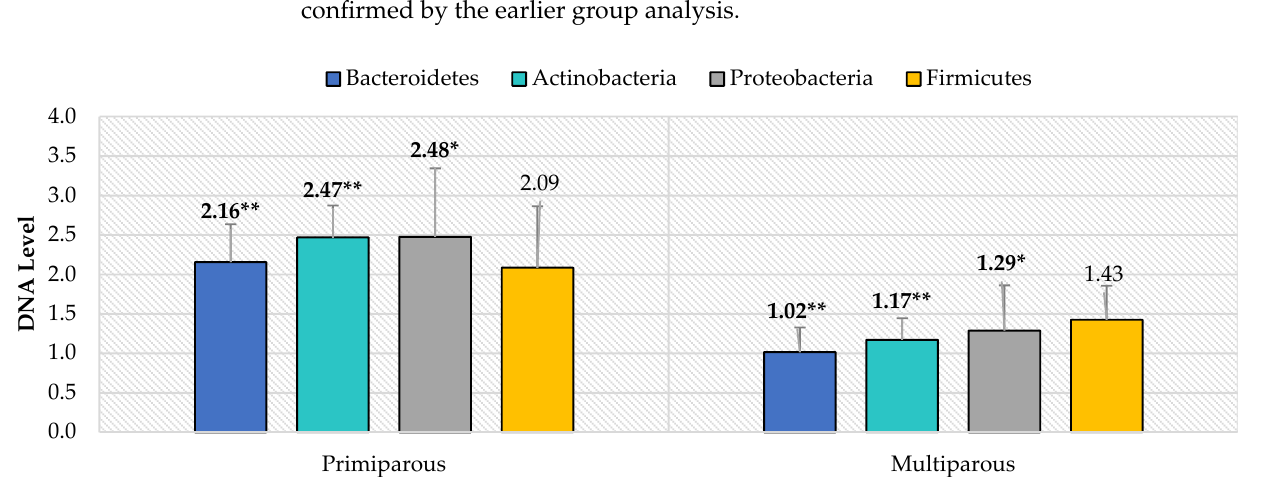
Figure 1. The level of selected bacterial phyla (RNE) in the gastrointestinal tract of ewes in relation to the parity based on feces (* p < 0.05; ** p < 0.01).